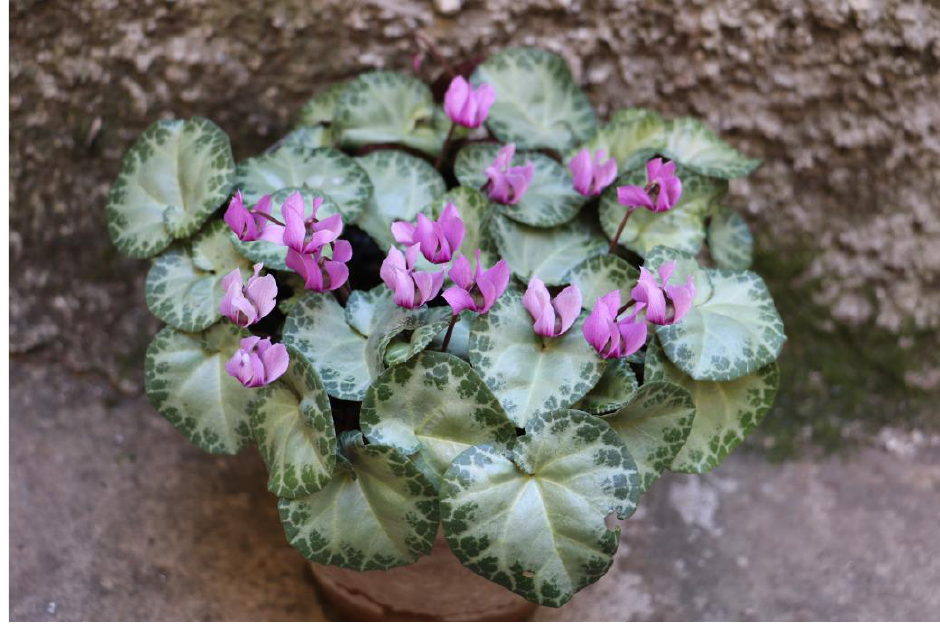
Figure 9. Cyclamen purpurascens ‘Idrija’.